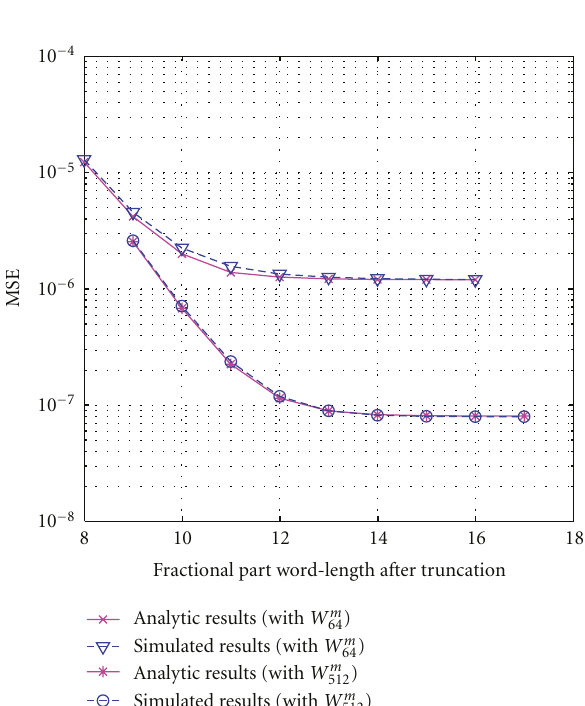
Figure 7: Analytic and simulated quantization mean squared error after